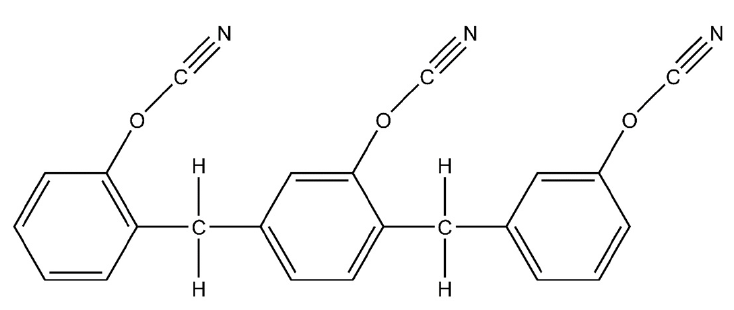
Figure 5. Molecular structure of fluorinated cyanate ester.